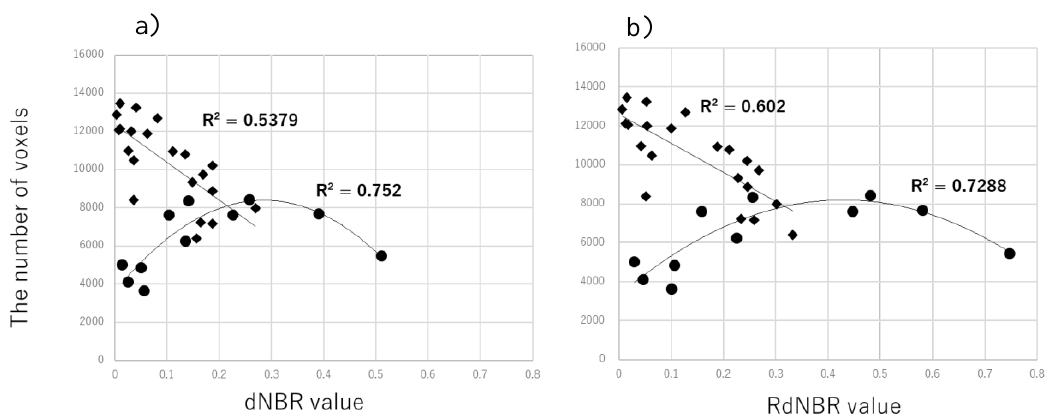
Figure 4. The relationship between the total number of voxels at each plot and ( a ) dNBR and ( b ) RdNBR values (marker ● : recently burned plots, ♦ : unburned plots, the bold fonts of R 2 values are statistically significant for the linear case and not-significant for the non-linear case with a significant level of 0.05).